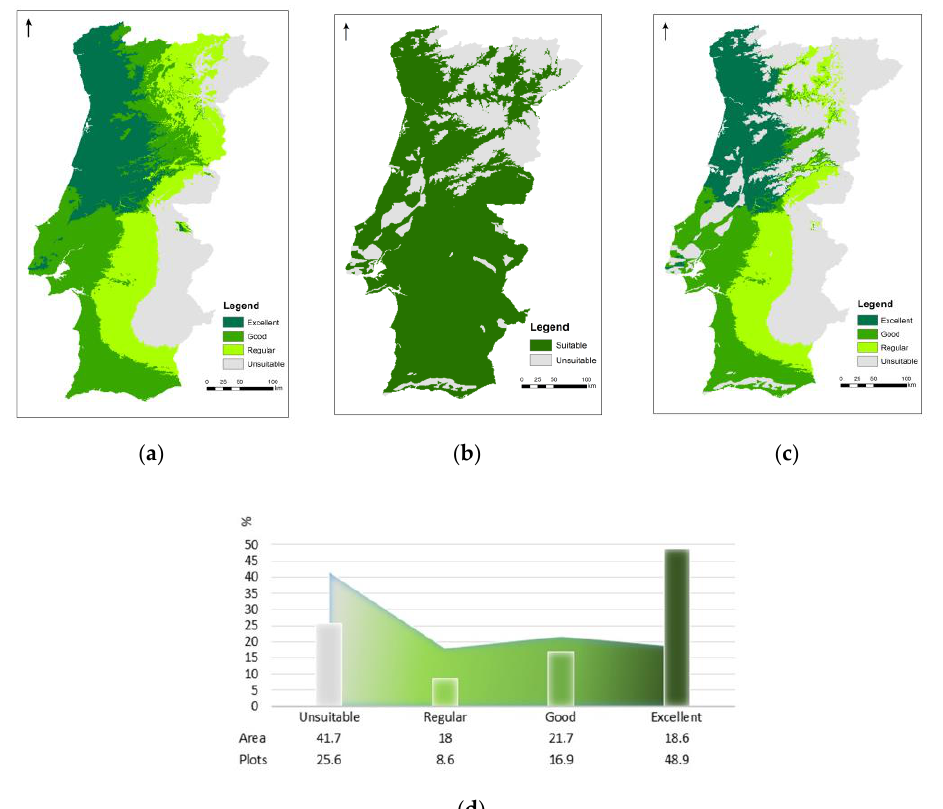
Figure 7. Maritime pine potential distribution (i.e., ecological envelope) map algebra. ( a ) Temperature annual range, temperature limits and precipitation ranking ( BIO7 + ( BIO6 × BIO5 ) + BIO12 ). ( b ) Elevation and soil constrains ( E × WRFBU ). ( c ) Potential distribution map (( BIO7 + ( BIO6 × BIO5 ) + BIO12 ) × E × WRFBU ); and ( d ) area (ha) and plots distribution (%) by suitability class. Legend: Excellent (sum equal 3—without temperature range, temperature limits and precipitation limitations); 2—Good (sum equals 2—with one limitation); 1—Regular (sum equals 1—with two limitation); 0—Unsuitable (null); Boolean maps (0—Not suitable,